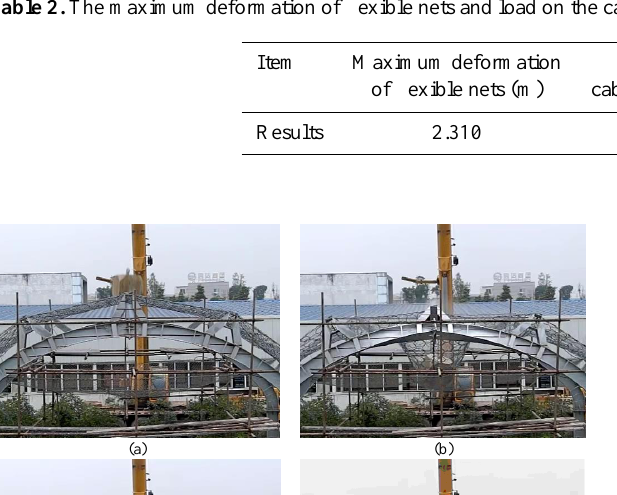
Table 2. The maximum deformation of flexible nets and load on the cable anchor and horizontal cable.